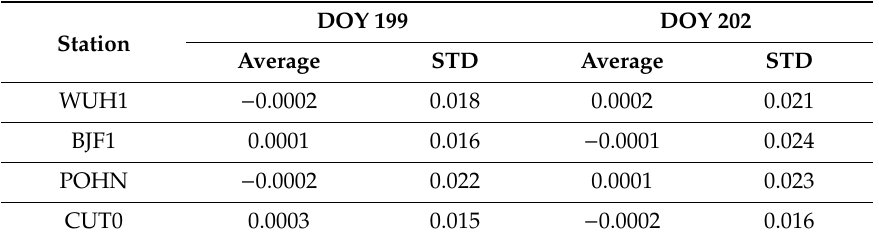
Table 3. Statistics of the L array during the non-maneuver period